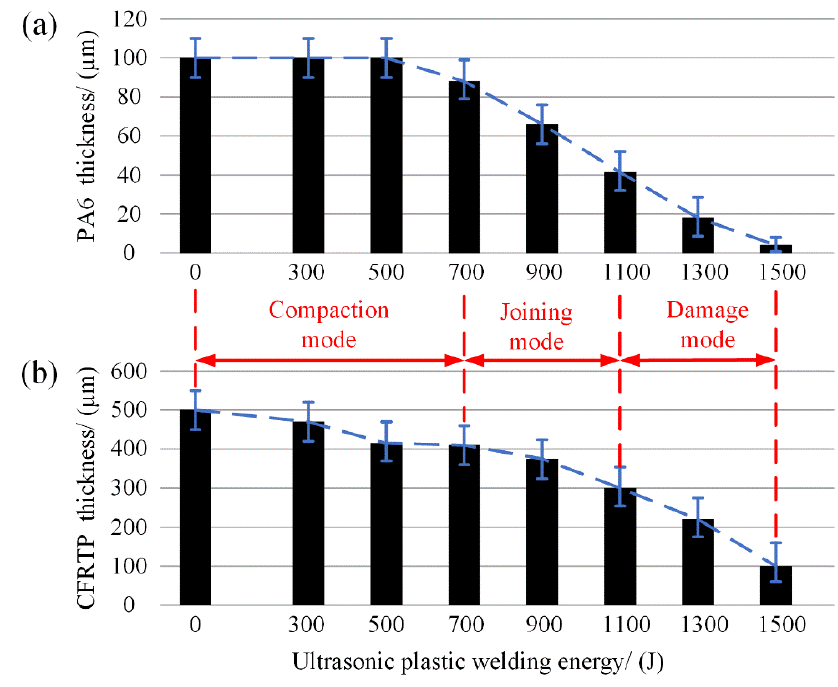
Figure 14. The trend of the thickness variation: ( a ) PA6 film; ( b ) CFRTP chopped sheet.